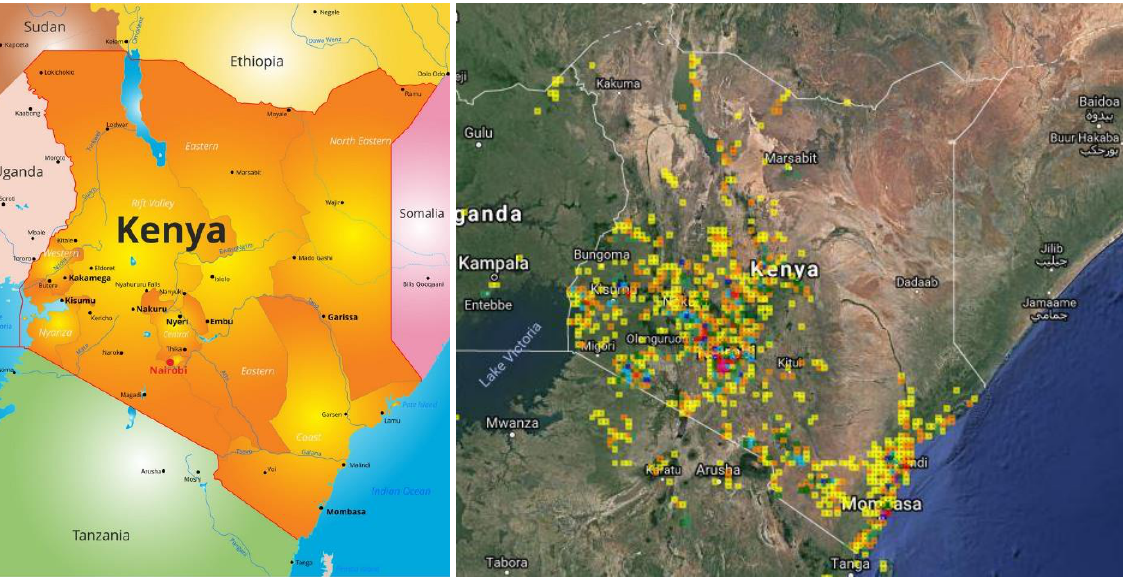
Figure 1. Kenya Bird Map Project